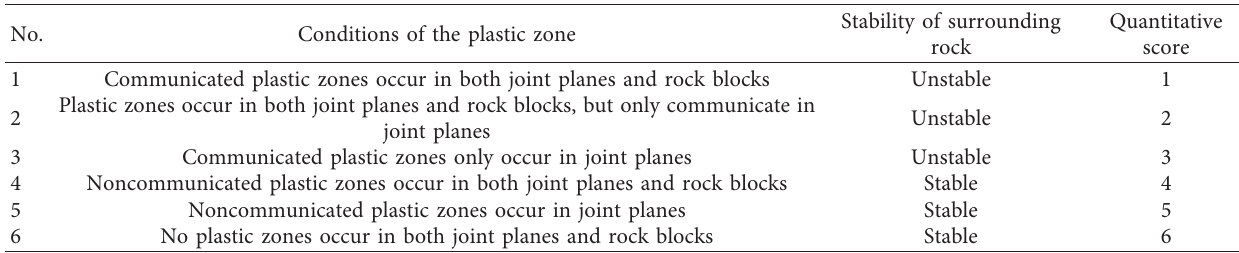
Figure 2: Calculation model of no. 1 test. Table 5: Criterion and quantitative standard of surrounding rock stability